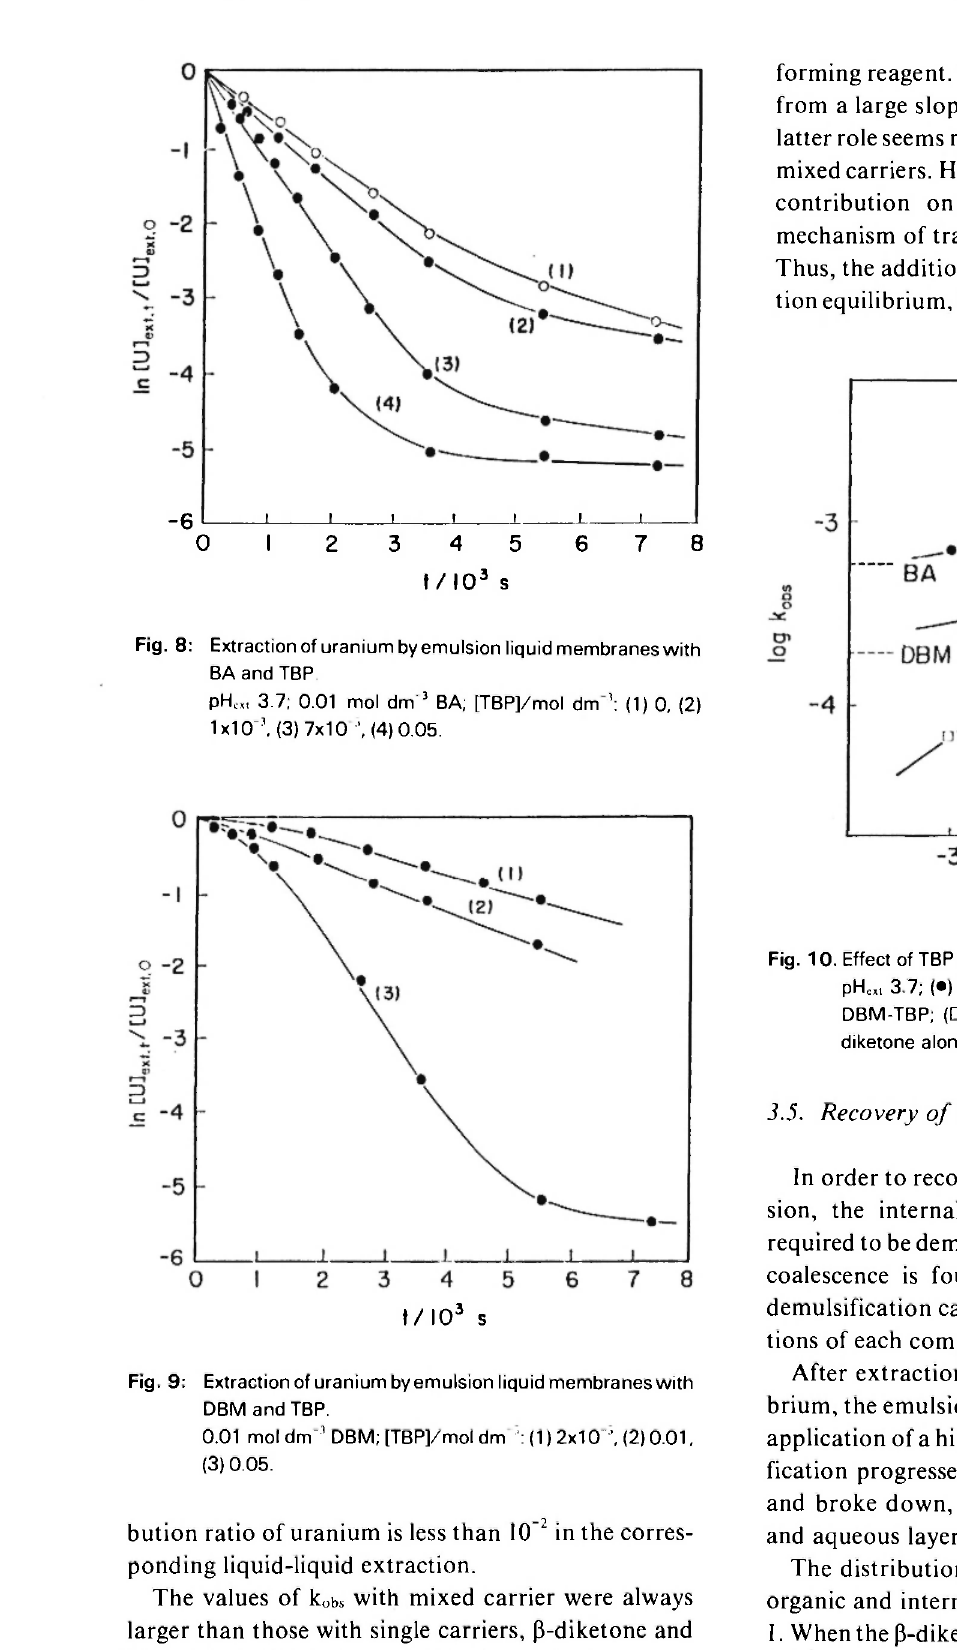
Fig. 8: Extraction of uranium by emulsion liquid membranes with BA and TBP